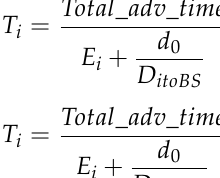
Figure 5. Data transmission Phase.